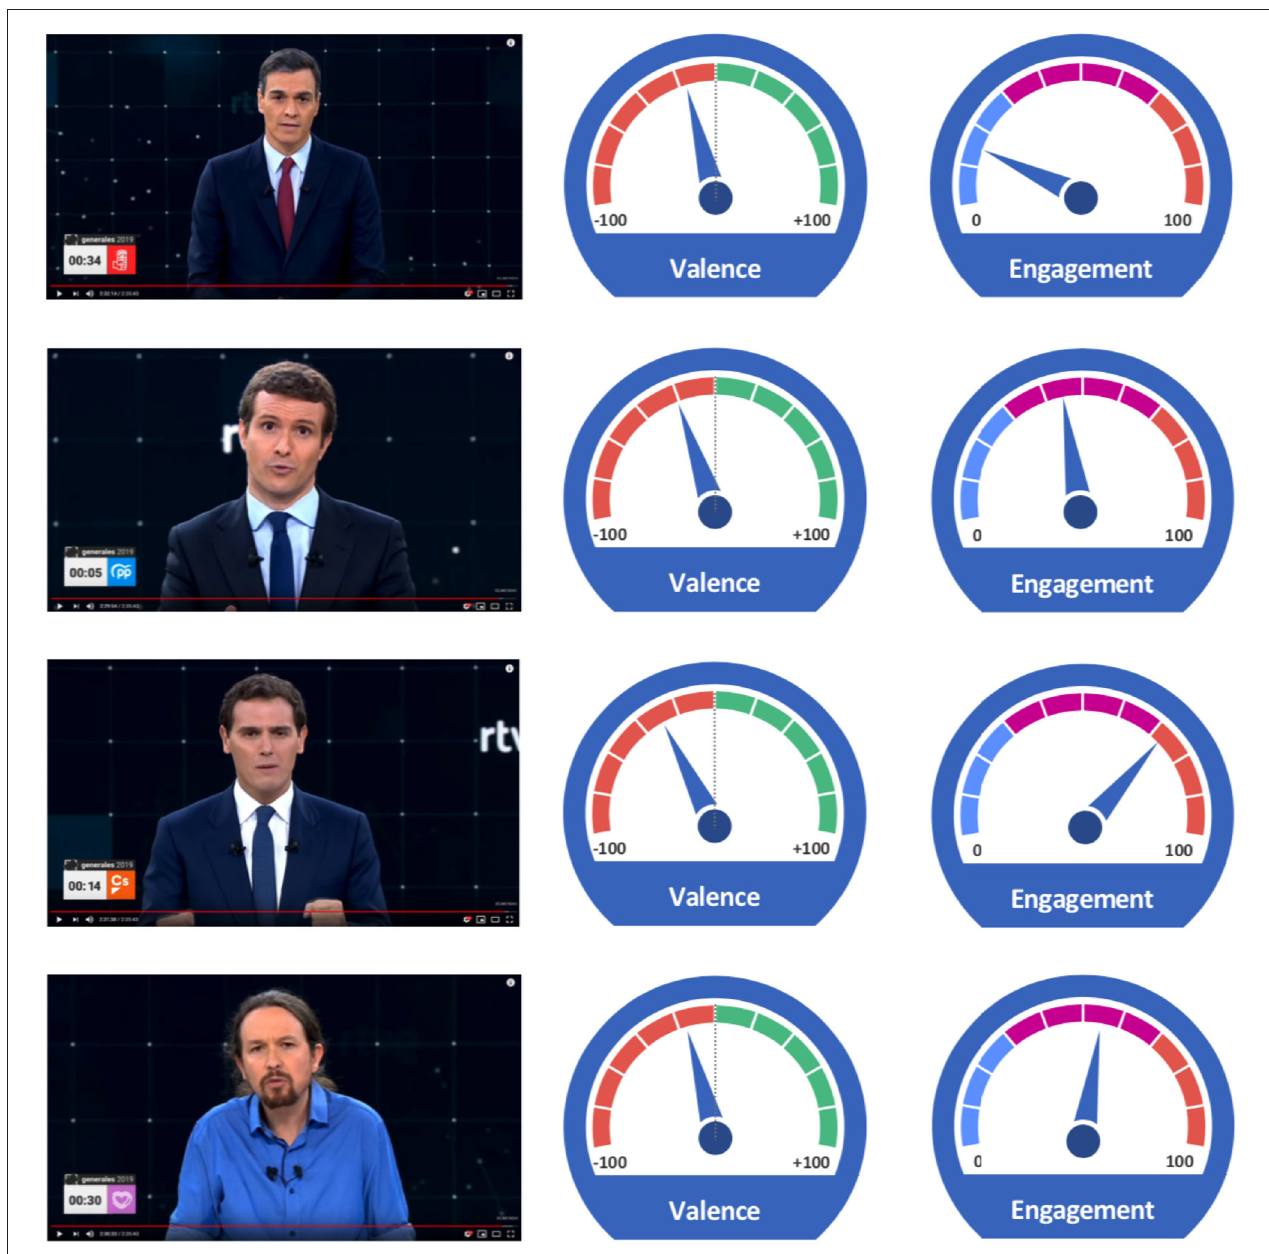
FIGURE 4 | Comparison of the average values of valence and engagement shown by each candidate during the period